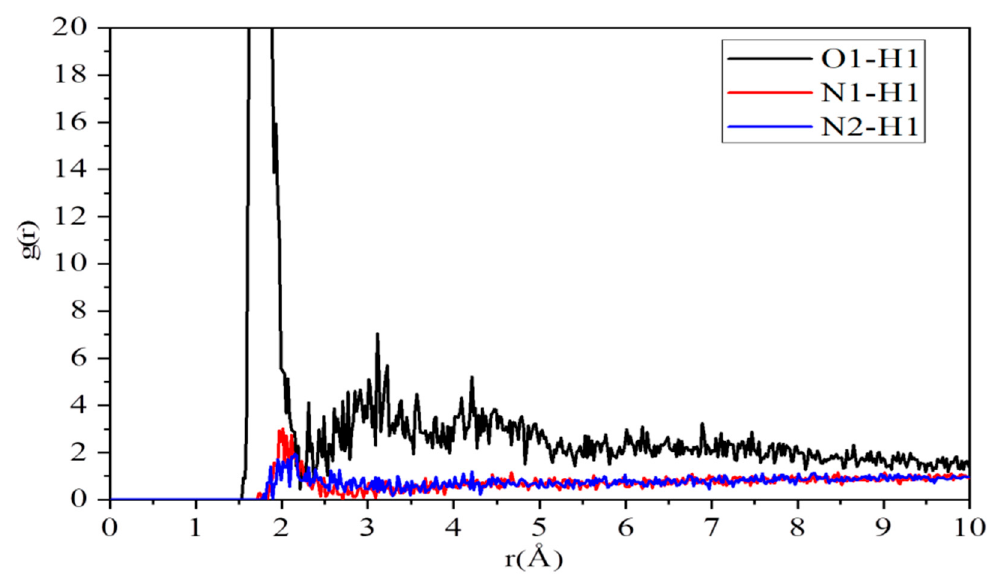
Figure 4. Intermolecular pair correlation functions of O1–H1, N1–H1 and N2–H1. Table 1. The maxima of the radial distribution functions and the coordination numbers of the selected atom pairs. Correlation Pair Position of Highest Peak Coordination